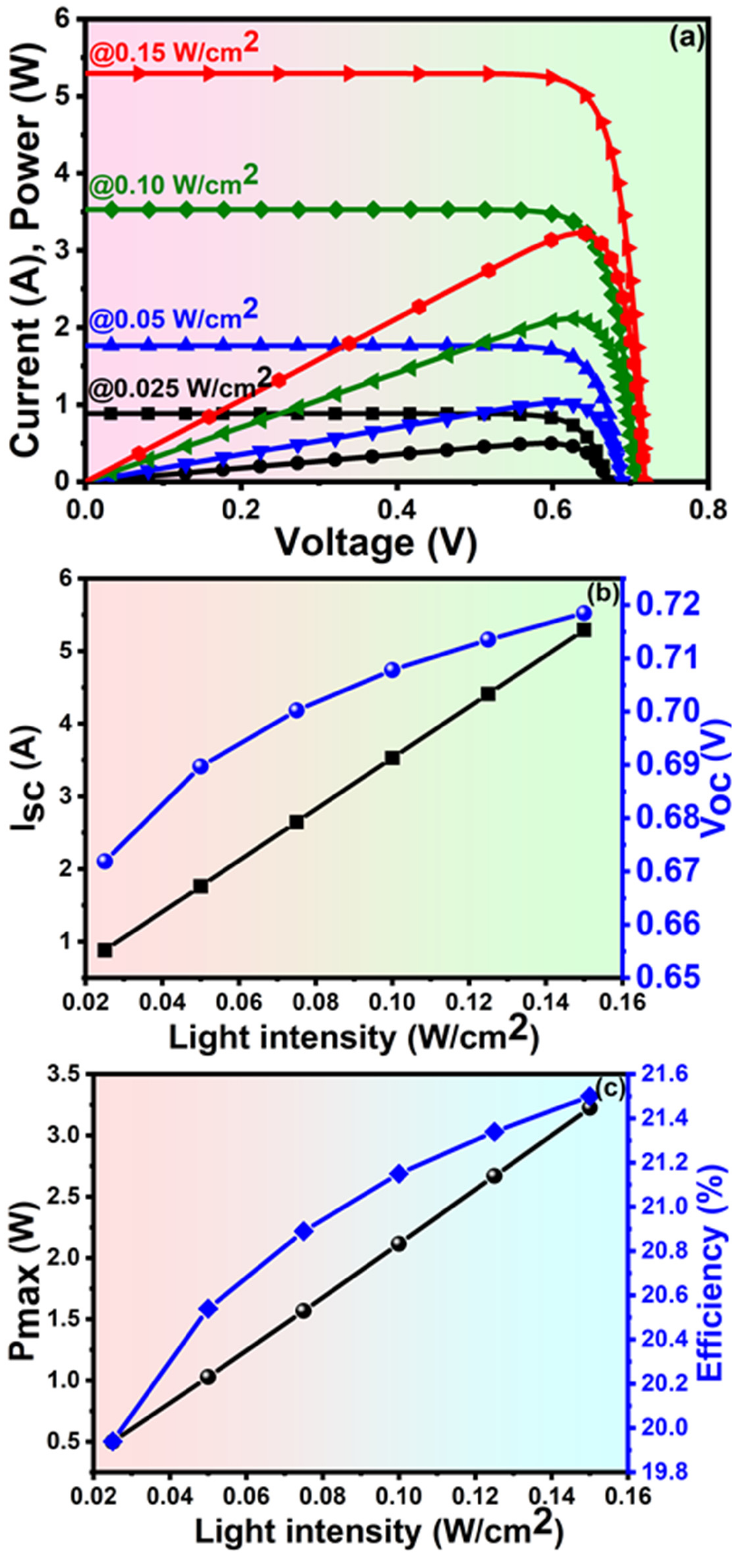
Figure 10. Analysis of ( a ) I, P-V characteristic ( b ) I sc &V oc ( c ) P max & Efficiency with the different light intensity of HfO 2 ARC layer-based c-Si solar cell.